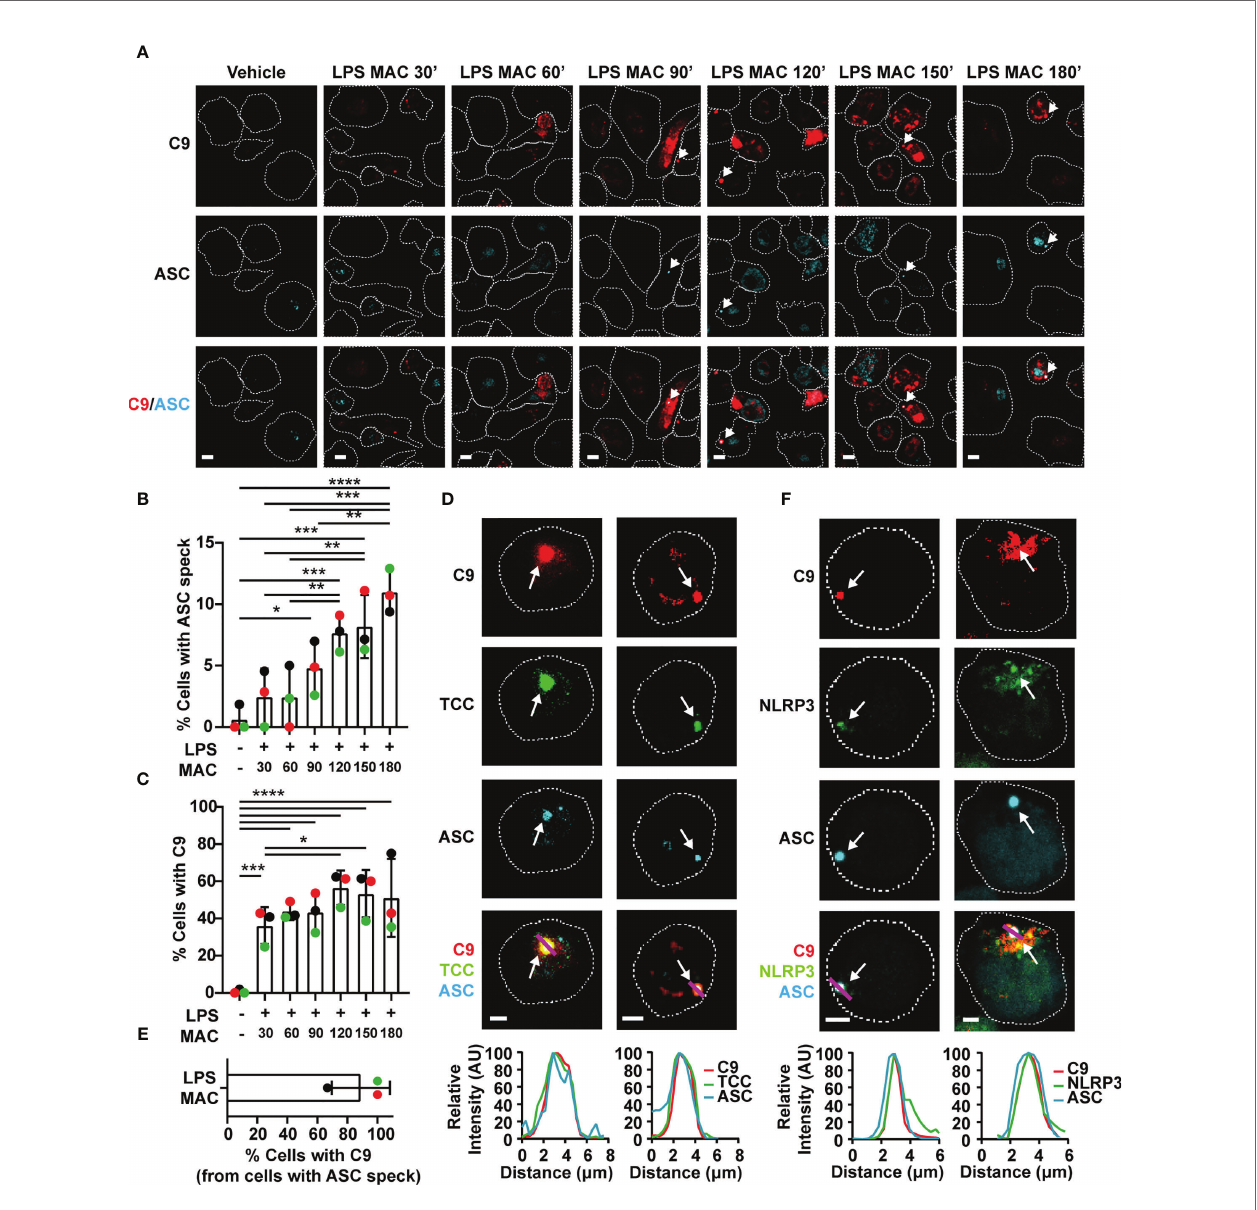
FIGURE 3 | The MAC triggers in fl ammasome assembly and localizes to the NLRP3-ASC speck. (A – F) Human MDMs (A – E) and THP1 nlrp3-/- /eGFP-nlrp3 cells (F) were treated with vehicles or primed with 1 µg/mL LPS for 3 hrs followed by stimulation with 10 µg/mL anti-CD59 mAb, C5b6, C7, C8 and C9 labelled with JF-549 (MAC) for the indicated time (A – C) or 3hrs (D – F) . (A) Representative confocal images of C9 (red) and ASC (cyan) overtime. (B) Percentage of cells with ASC specks over time. (C) Percentage of cells with C9 over time. (D) Confocal imaging of C9 (red), ASC (cyan) and TCC (green). (E) Percentage of ASC speck positive cells with C9 in the speck. (F) Confocal imaging of C9 (red), ASC (cyan) and NLRP3 (green). (A, D, F) Dashed lines represent the outline of the cell, arrows point to specks, magenta lines correspond to the plotted line pro fi les and scale bars are 10 µm (A) and 5 µm (D, F) . (B, C, E) Data is plotted as mean±SD, each color represents a matched donor. (B, C) Statistical signi fi cance was measured by one-way ANOVA (*p < 0.05, **p < 0.01, ***p < 0.001, ****p < 0.0001). (A – F) Data is representative of 3 independent